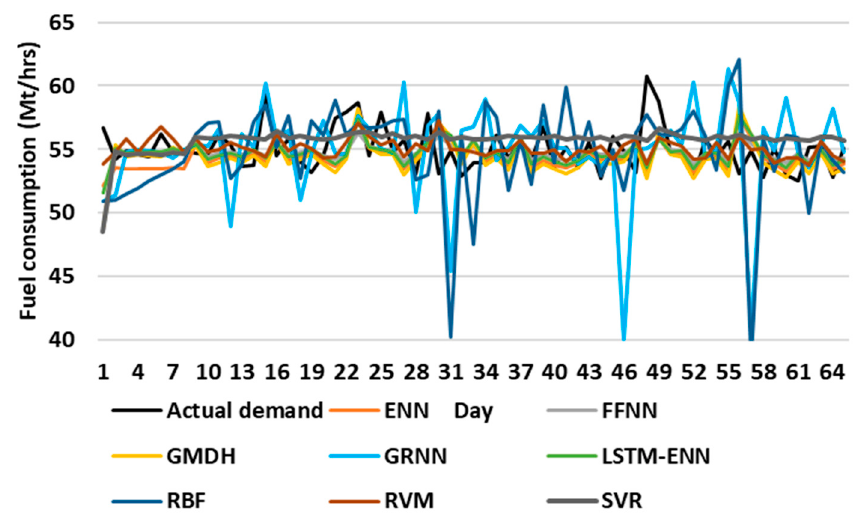
Figure 13. Actual demand and forecasts for Test Case #1.